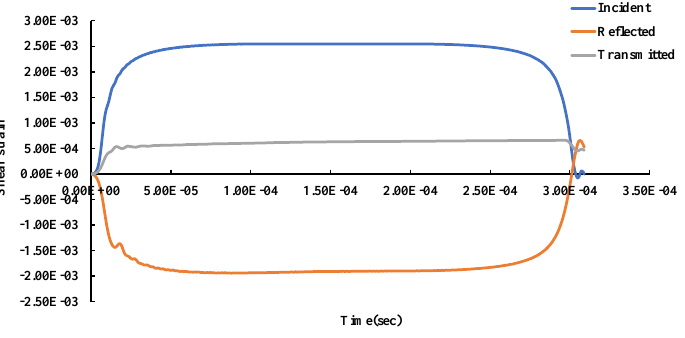
Fig. 8. Time synchronized shear strain